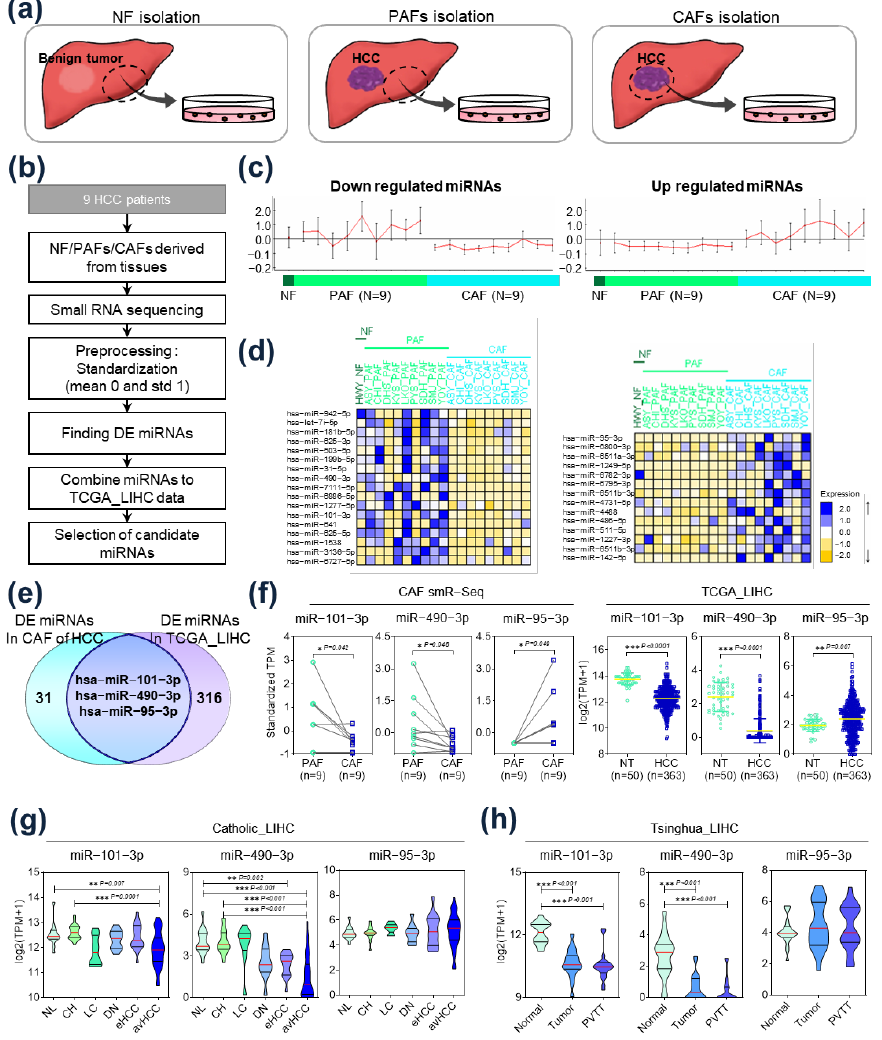
Figure 1. Identification of differentially expressed miRs in hepatocellular carcinoma (HCC) cancer- associated fibroblasts (CAFs). ( a ) Isolation of CAFs, para-cancer fibroblasts (PAFs), and normal fibroblasts (NFs) from surgically resected liver tissues. ( b ) Flow chart of this study’s protocol for selecting CAF-derived miRs in HCC. ( c ) Expression of upregulated (right panel) and downregulated (left panel) miRs in CAFs compared to NFs and PAFs. ( d ) Heatmaps of differentially expressed miRs. Left: heatmap of the 17 downregulated miRs; right: heatmap of the 14 upregulated miRs. ( e ) Venn diagram of differently expressed miRs in CAFs and in TCGA_LIHC. ( f ) Comparison of expression of hsa-miR-101-3p , hsa-miR-490-3p , and hsa-miR-95-3p in CAFs compared to PAFs (left) and in HCC tissue compared to non-tumor tissue in TCGA_LIHC (right). ( g ) Clinical-stage analysis of hsa-miR-101-3p , hsa-miR-490-3p , and hsa-miR-95-3p in Catholic_LIHC. Expression of the miRs in normal cases, chronic hepatitis, liver cirrhosis, dysplastic nodule, early HCC, and advanced HCC. ( h ) Clinical-stage analysis of hsa-miR-101-3p , hsa-miR-490-3p , and hsa-miR-95-3p in Tsinghua_LIHC. Expression of the miRs in normal tissues, tumor tissues without portal vein tumor thrombosis, and tumor tissues with portal vein tumor thrombosis. * p < 0.05; ** p < 0.01; *** p <